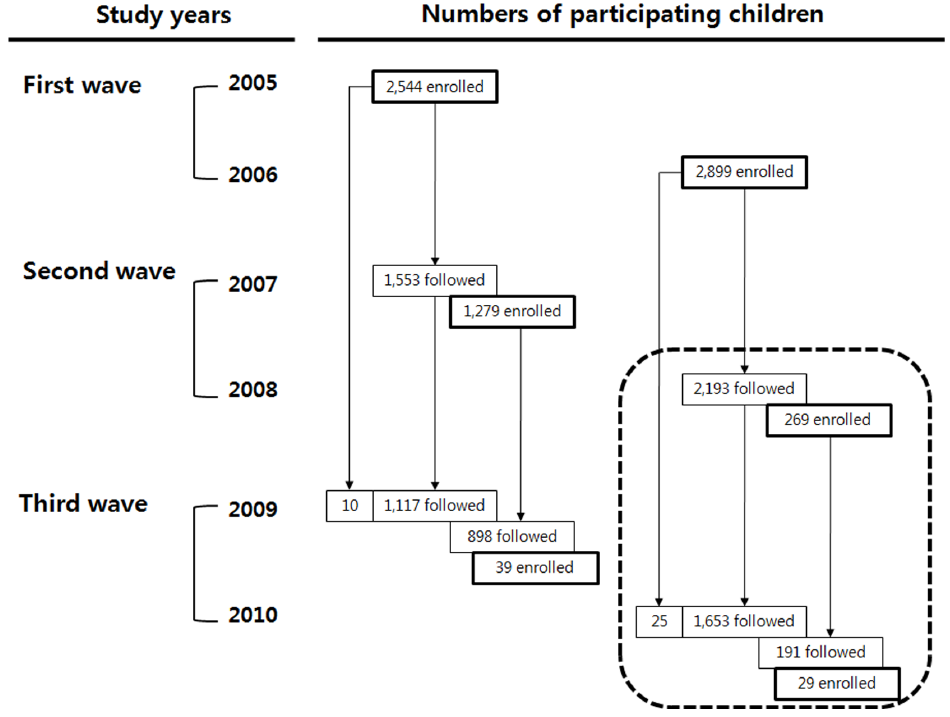
Figure 1. Number of children participating in the CHEER study by survey years. Of 2,516 children at baseline in 2008 and 2010 shown as the dotted lined box, 2,422 were included after excluding children with incomplete questionnaire responses on mobile phone use or a lack of blood lead measurements in 2008 and 2010.